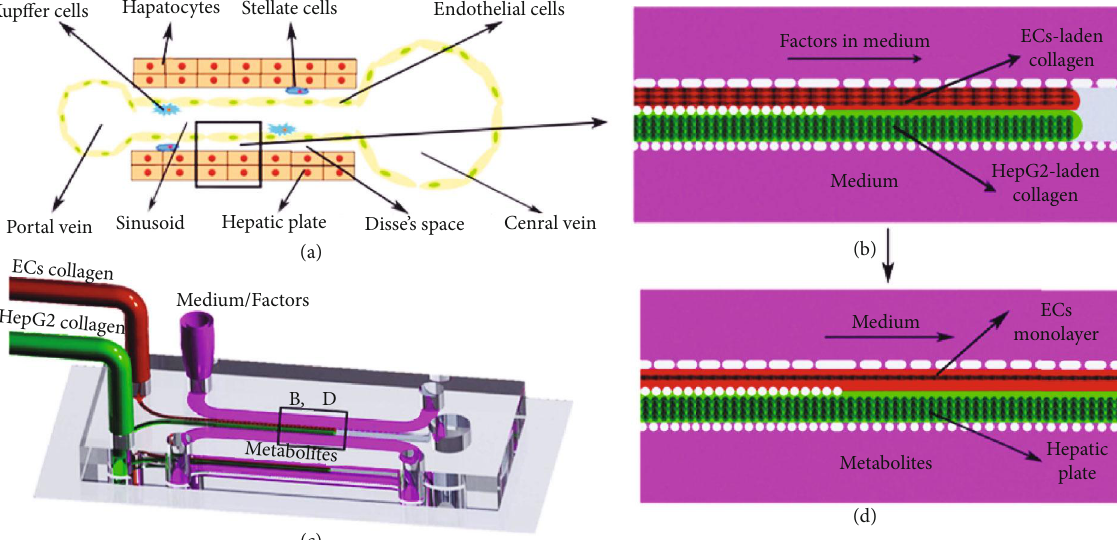
Figure 2: Formation of the biomimetic liver sinusoid on a chip. (a) Schematic diagram of a liver sinusoid. Hepatic plates and endothelial cell (EC) monolayers are the main part of this unit. (b) Injection of cell-laden collagen and medium with factors. (c) The 3D schematic diagram of collagen and medium injection process. (d) After the stimulation of factors for two days, an EC monolayer formed and medium with factors was changed to medium without factors, forming the liver sinusoid on a chip. Reproduced (or adapted) with permission [41], ©2018, IOP Science.